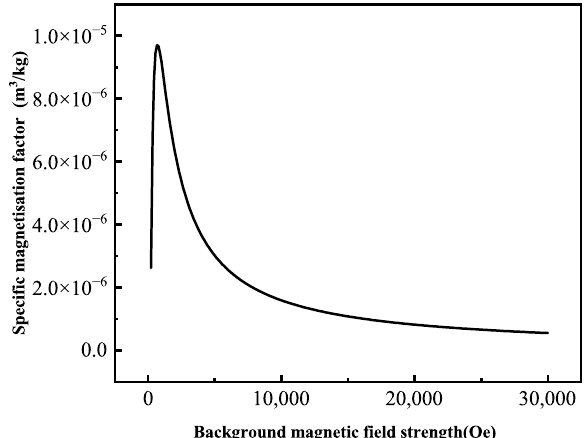
Figure 2. VSM results of raw